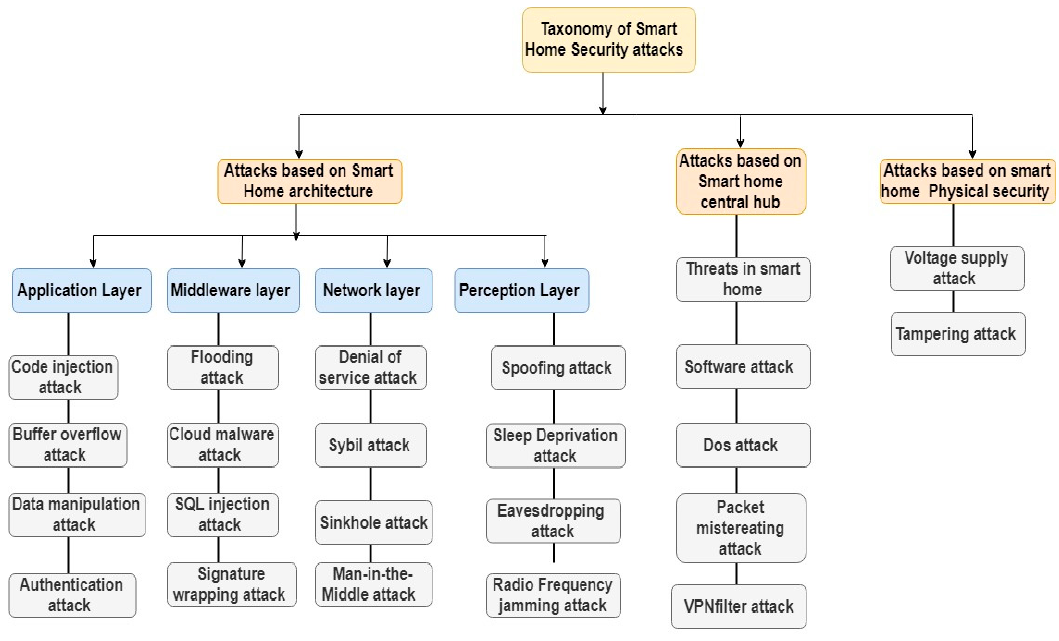
Figure 2. Taxonomy of malware attacks in the smart home .